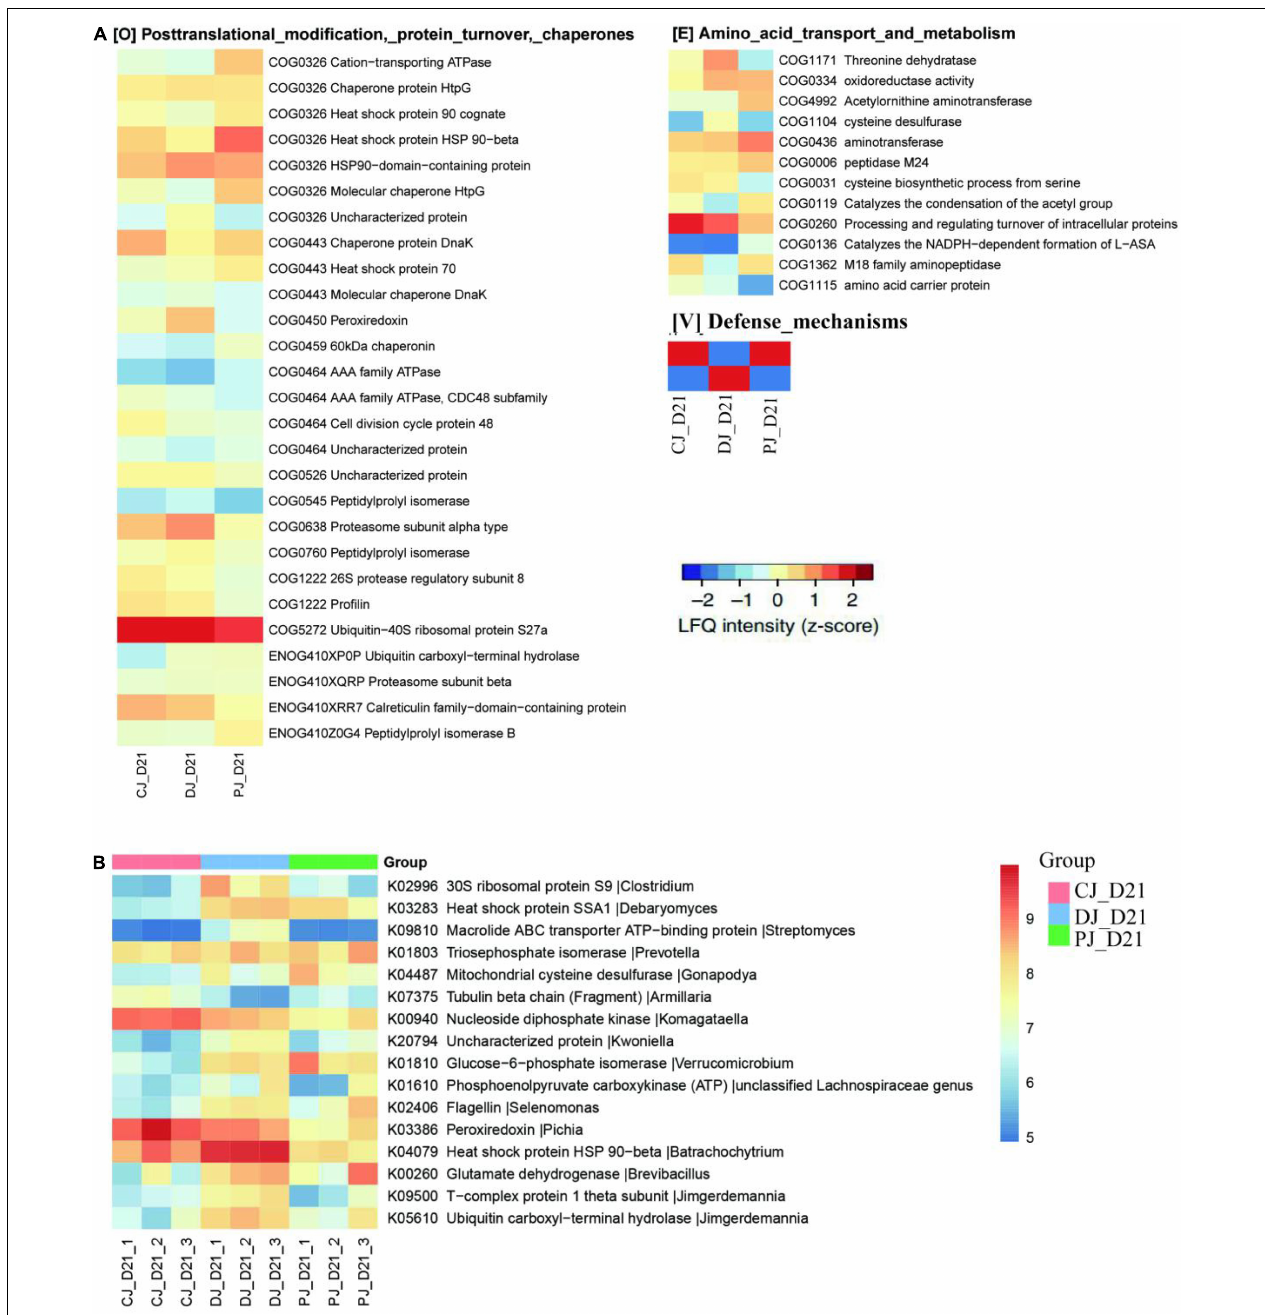
FIGURE 6 | Functional compositions of the microbiome in neonatal calves infected by E. coli K99. (A) Heatmap of differentially abundant COGs in neonatal calves. Representative COG categories are shown, and the colors indicate the average LFQ intensity for each subgroup of samples. Each row corresponds to a COG with the COG ID and name indicated. (B) Heatmap shows the average LFQ intensity for each group of samples. Each row represents one protein group, and the corresponding KO ID, KO name and taxonomic assignment are shown in the right panel.